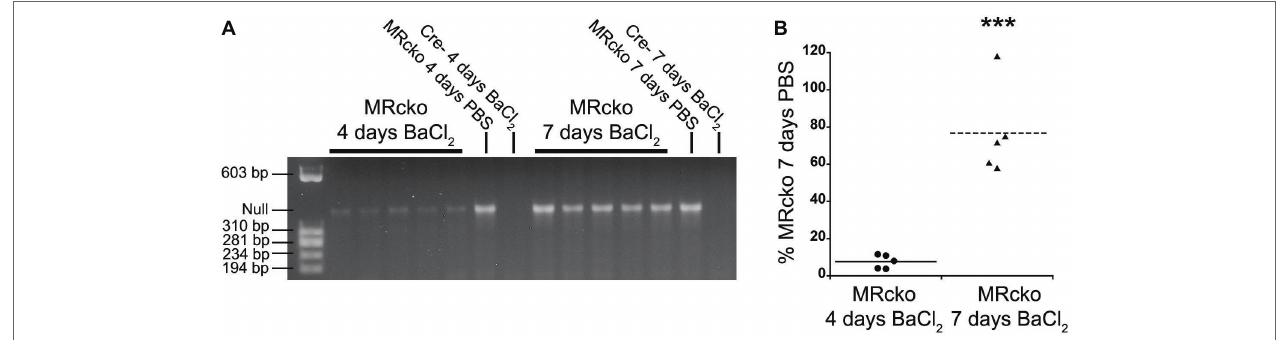
FIGURE 2 | Evaluation of MRcko excision after acute muscle injury. (A) PCR was run to detect the level of MR excision by presence of the MR null allele in TAs from mice at 4 ( n = 5 MRcko barium chloride injection, n = 1 MRcko PBS injection, n = 1 Cre − barium chloride injection) and 7 ( n = 5 MRcko barium chloride injection, n = 1 MRcko PBS injection, n = 1 Cre − barium chloride injection) (two technical replicates) days post-injury. (B) The level of MR null allele at 4 and 7 days post-injury was quantified and normalized to the level of MR null allele from PBS injection at 7 days post-injury. There was restoration of MR excision at 7 days post- injury ( p = 0.0002). Means are shown by lines for each group in the dot plot. BaCl 2 , barium chloride injection; PBS, sterile phosphate buffered saline injection; TA, tibialis anterior ; data were analyzed using a Student’s t -test; *** p ≤ 0.001 compared to MRcko barium chloride injection at 4 days